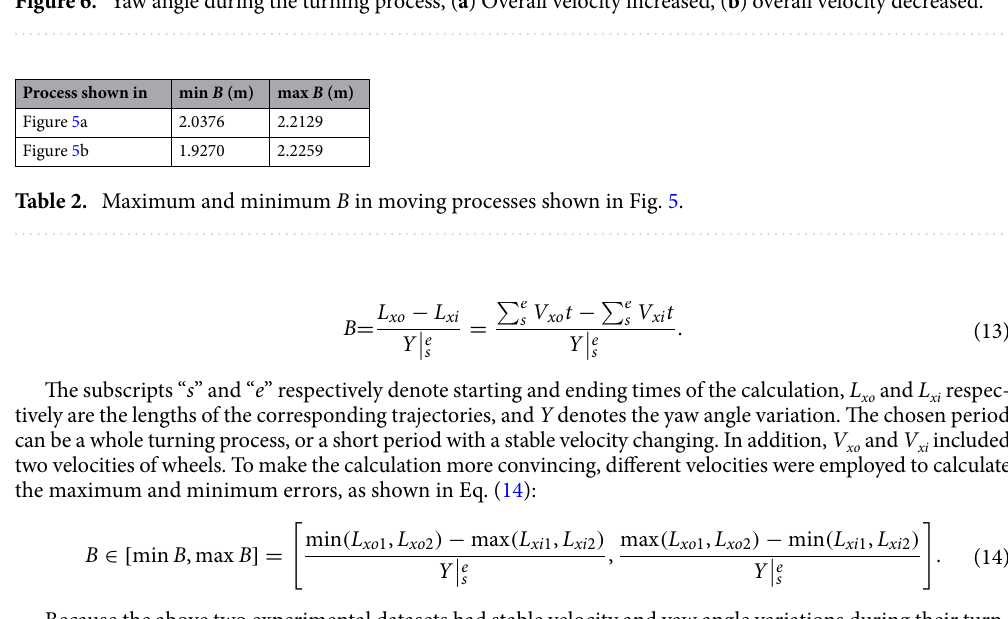
Figure 6. Yaw angle during the turning process, ( a ) Overall velocity increased, ( b ) overall velocity decreased.